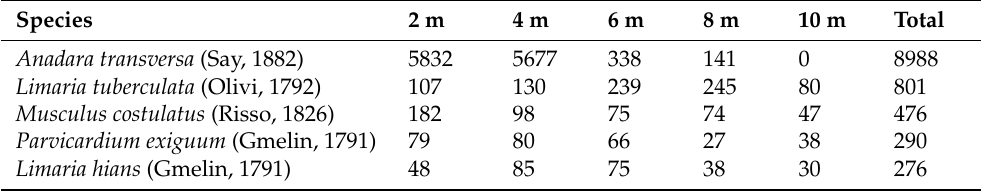
Table 2. The most abundant bivalve species on larval collectors in Javorike Cove in 2020. Species